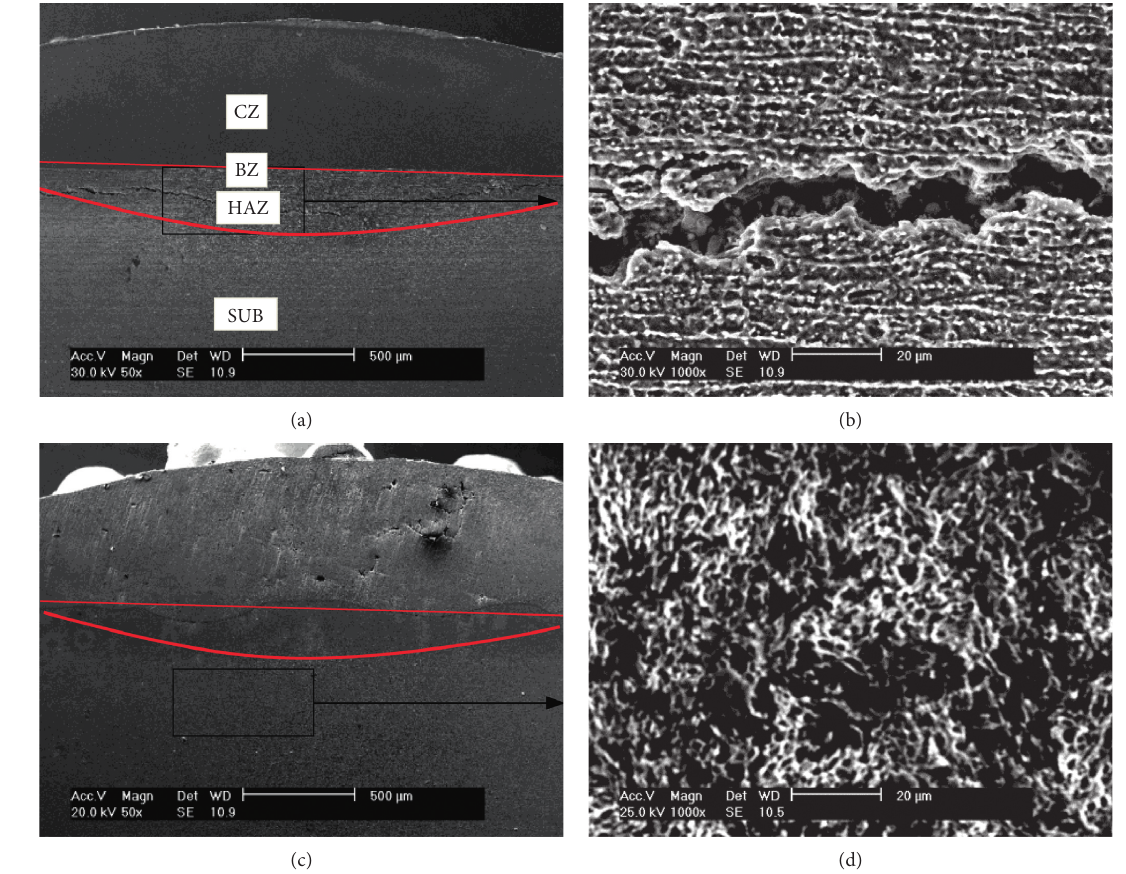
Figure 4: SEM of the A1 and B1 coating from the transverse cross section and heat-affected zone: (a) and (b) A1 coating; (c) and (d) B1